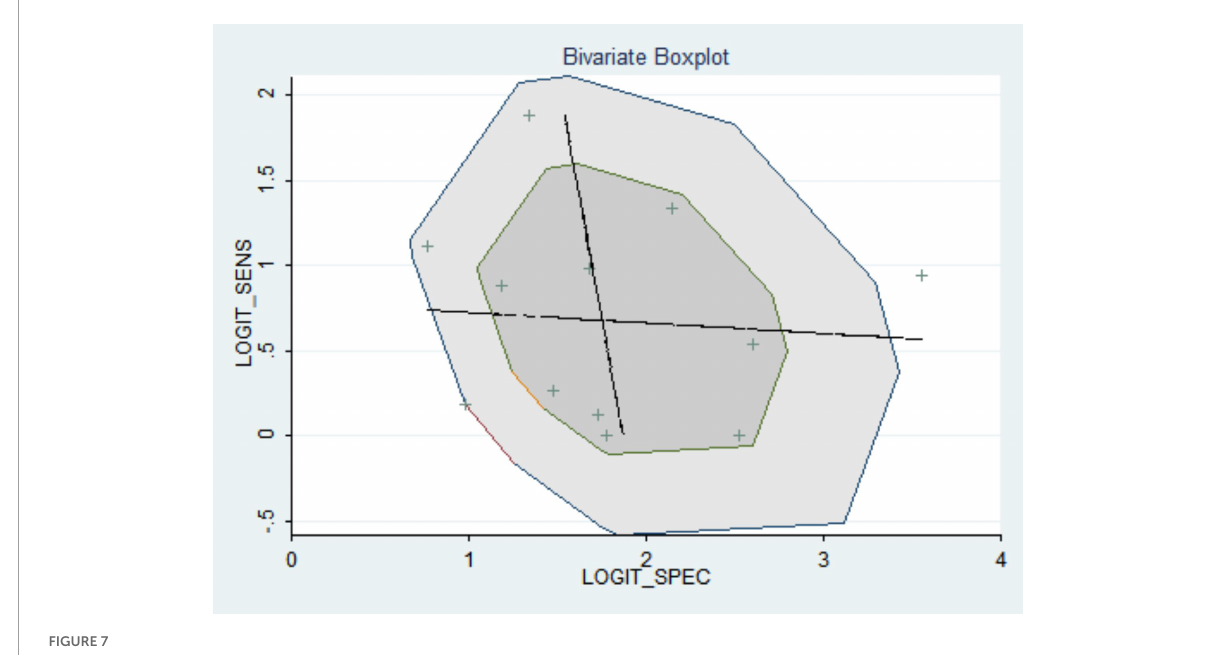
FIGURE7 Bivariate boxplot.